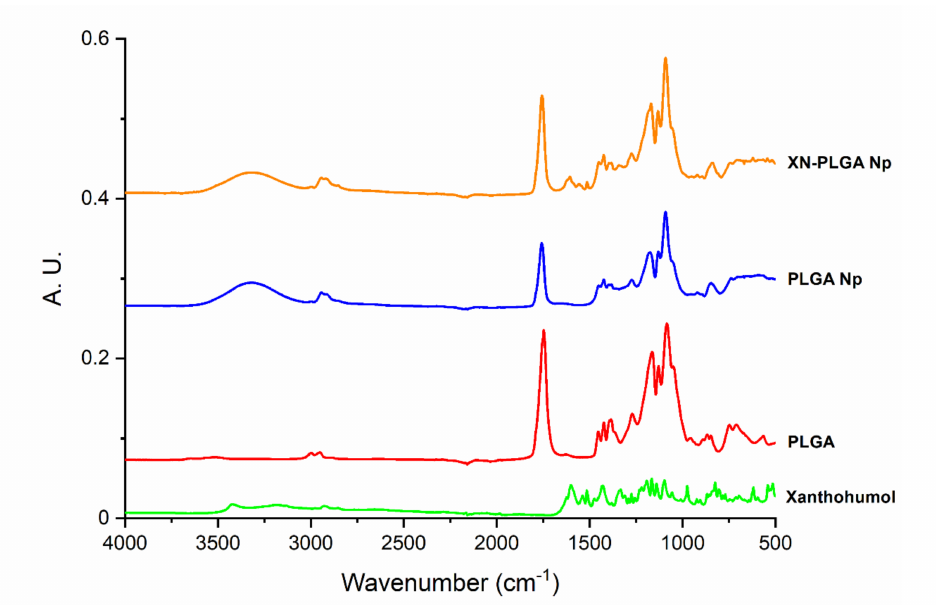
Figure 1. ATR-FTIR spectra of XN, PLGA, PLGA nanoparticles (PLGA Np), and XN-loaded PLGA nanoparticles (XN-PLGA